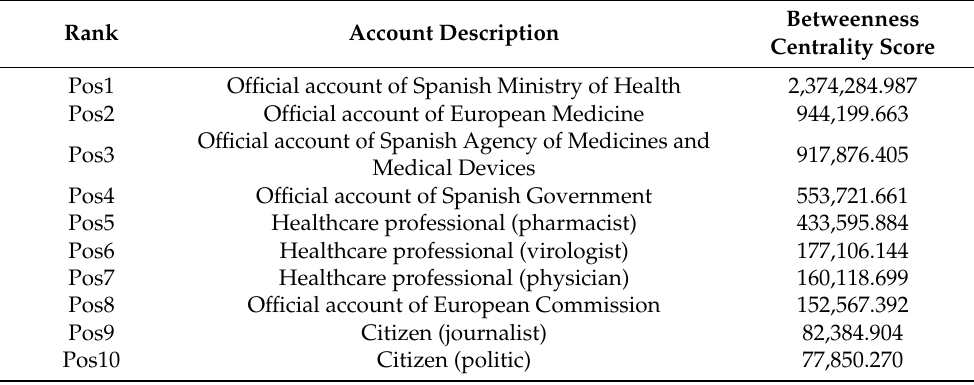
Table 2. Top ten influential users ranked in #yomevacuno network by their betweenness centrality score (which measure their influence over the flow of information in the